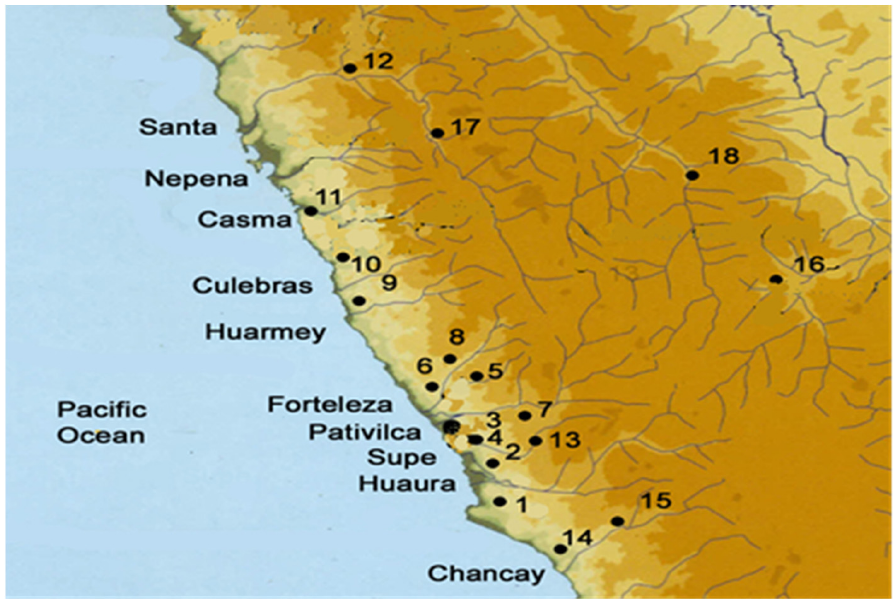
Figure 1. Site map of the coastal Norte Chico river valleys of Peru; the numbers represent major Archaic Period sites. Site 4 is Caral within the Supe Valley. Site 3 is Áspero. The North direction is in the vertical direction. The Chancay to Santa Valley distance is ~400 km.